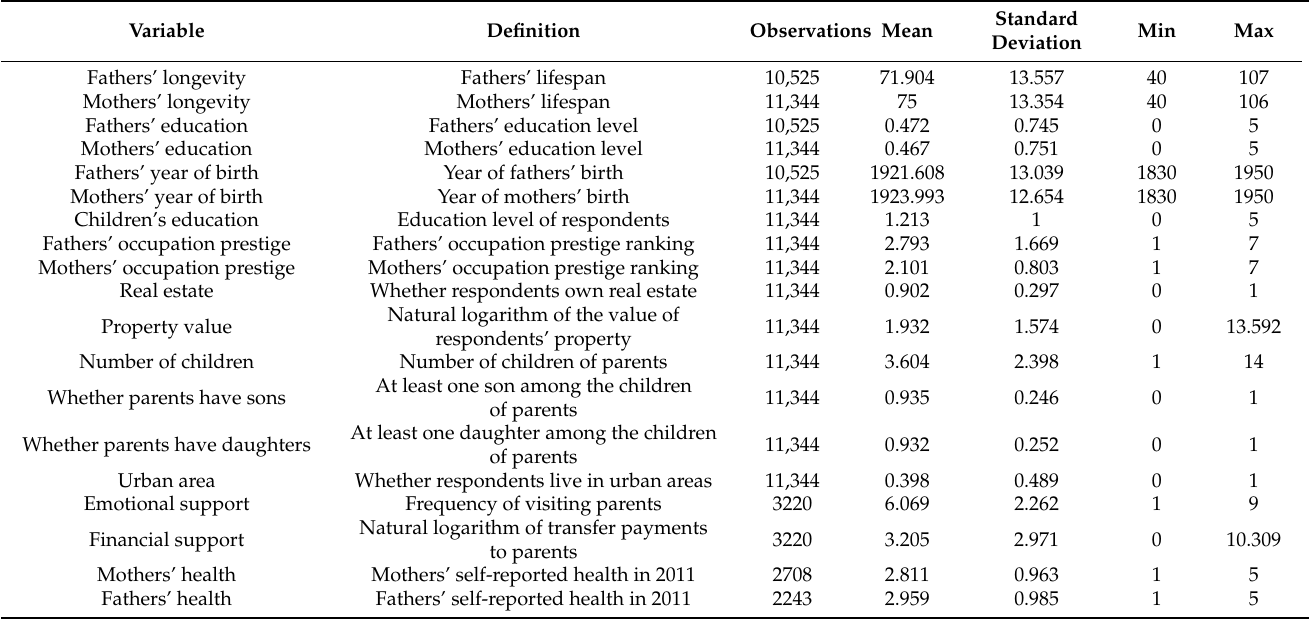
Table 1. Descriptive statistics of the